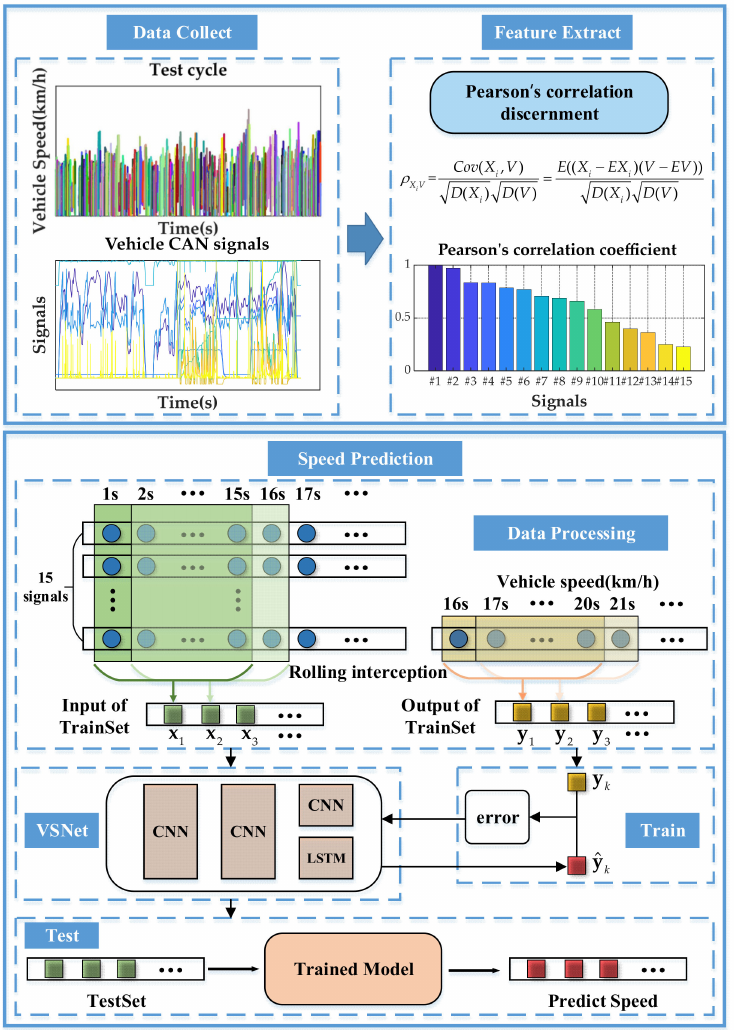
Figure 1. The flow chart of speed